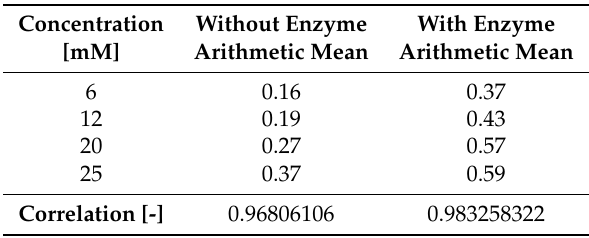
Table 3. Correlation table of Cu electrode.